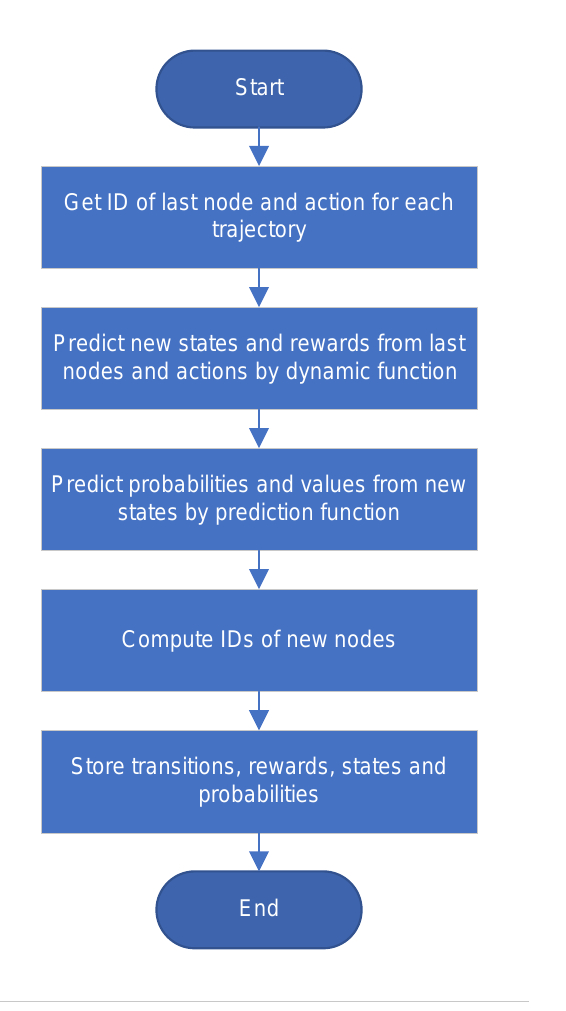
Figure 3. Flowchart of the phase of expansion and simulation. Algorithm 3 Phase of expansion and